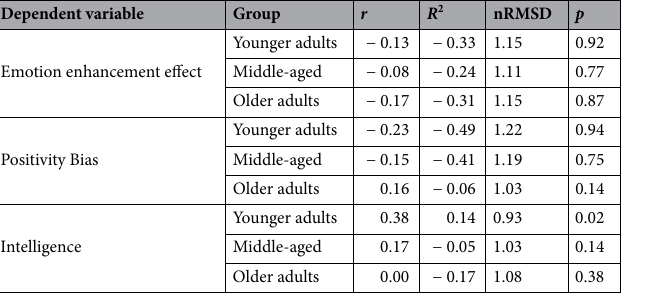
Table 4. Model prediction results of participants for each age group. For all analyses, we used Elastic Net, with ridge-lasso ratio = 0.01. The models were trained using leave-one-out cross-validation. p values were calculated as the number of permutations with lower R 2 divided by